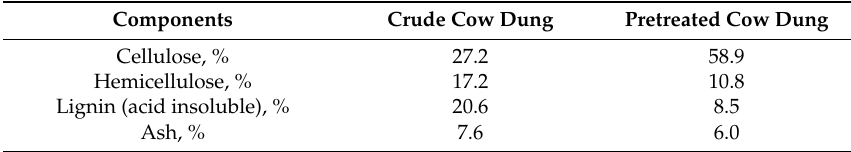
Table 1. Main chemical components of the crude and pretreated cow